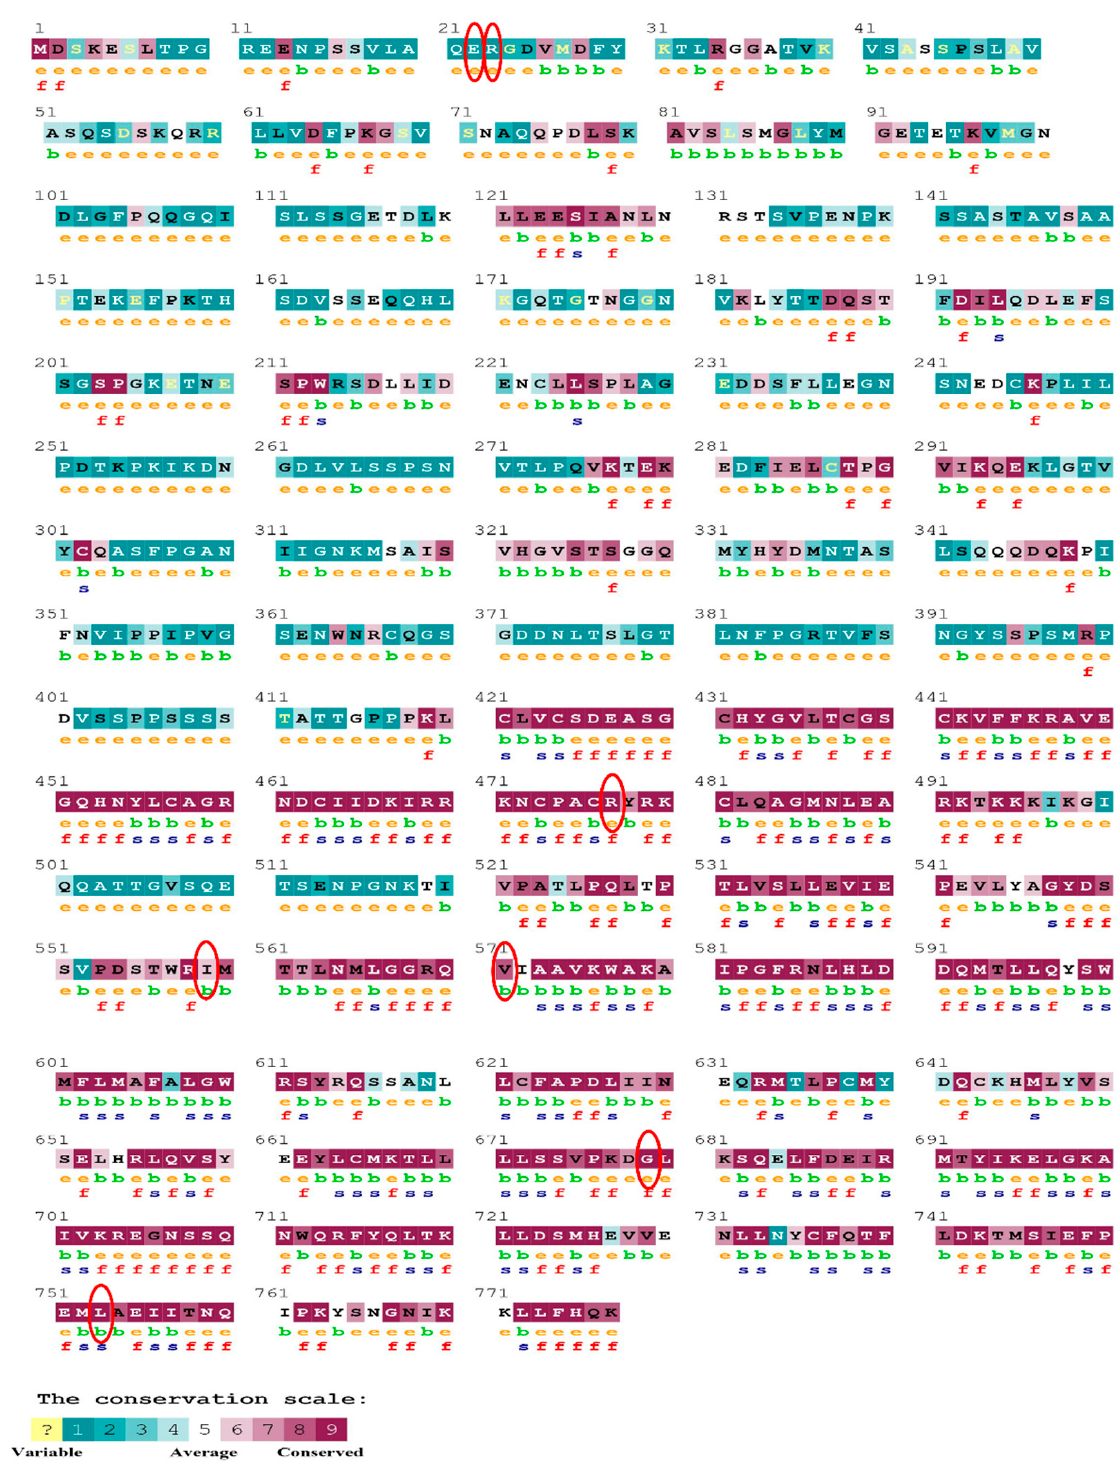
Figure 8. The ConSurf server predicted conserved amino acids in the NR3C1 protein. Based on the conservation scale, the amnio acids are ranked as variable, average, and conserved.